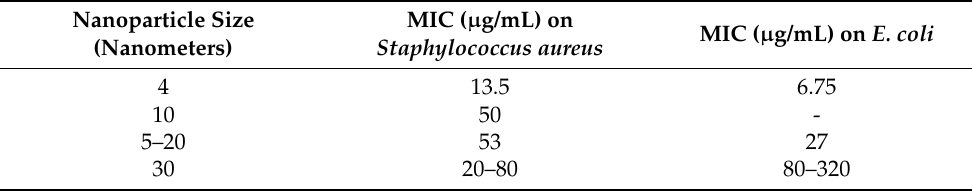
Table 3. Correlation between nanoparticles’ size and MIC in S. aureus and E. coli cultures.